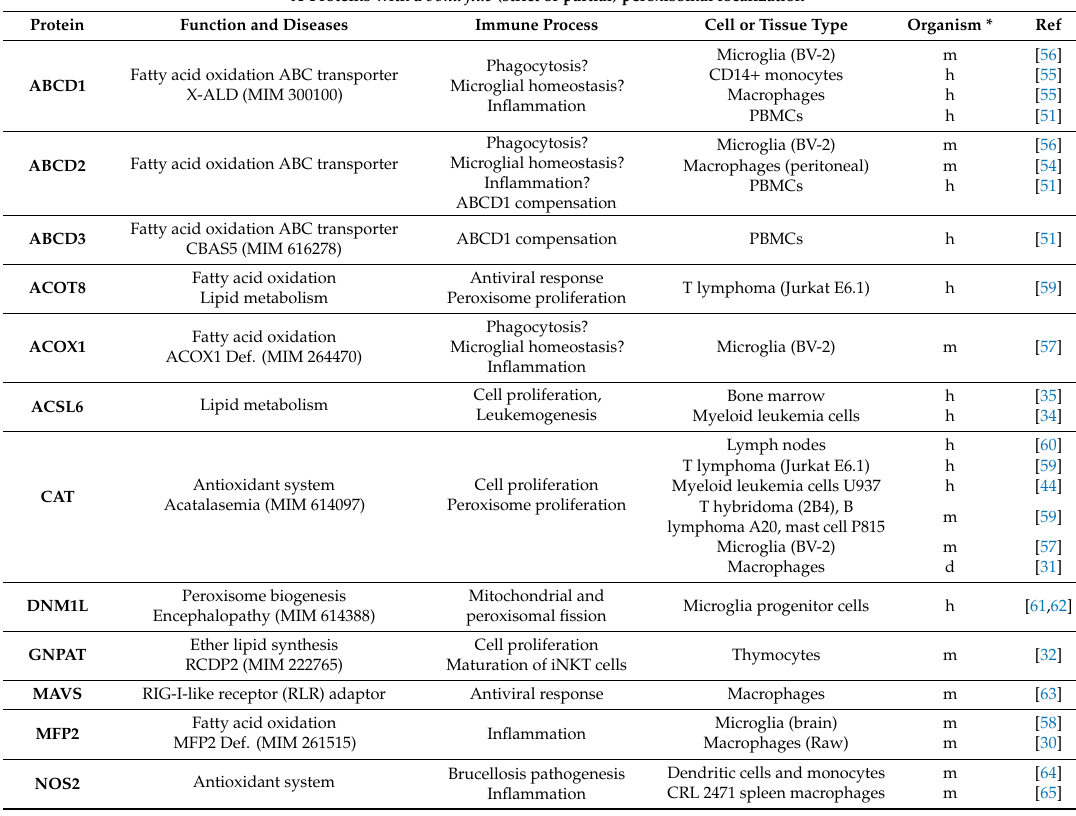
Table 1. A list of bona fide peroxisomal proteins ( A ) and proteins with an ambiguous peroxisomal localization ( B ) that are expressed in the immune cells and tissues and suggested to participate in the regulation of the immune